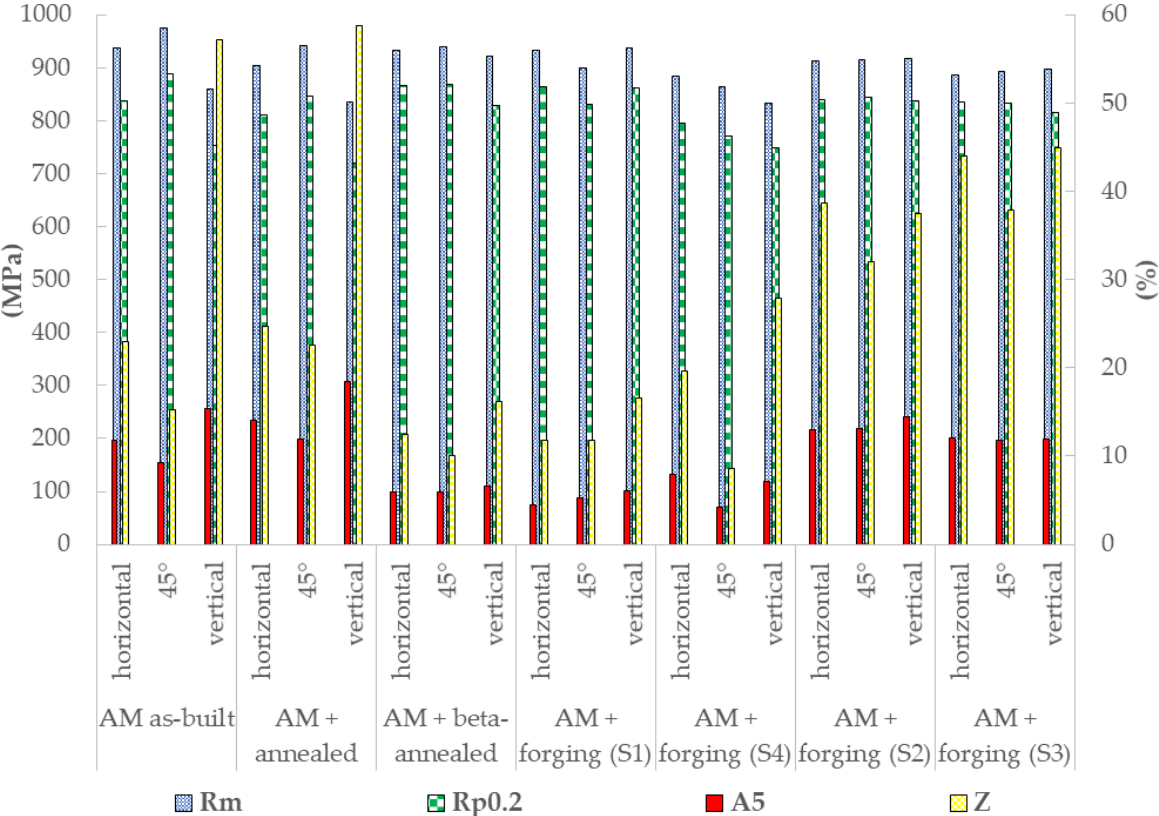
Figure 6. Comparison of tensile properties of hybrid manufactured (AM + forging) samples with L-DED manufactured Ti 64 tensile properties without thermomechanical processing (TMP) (data from [23]).